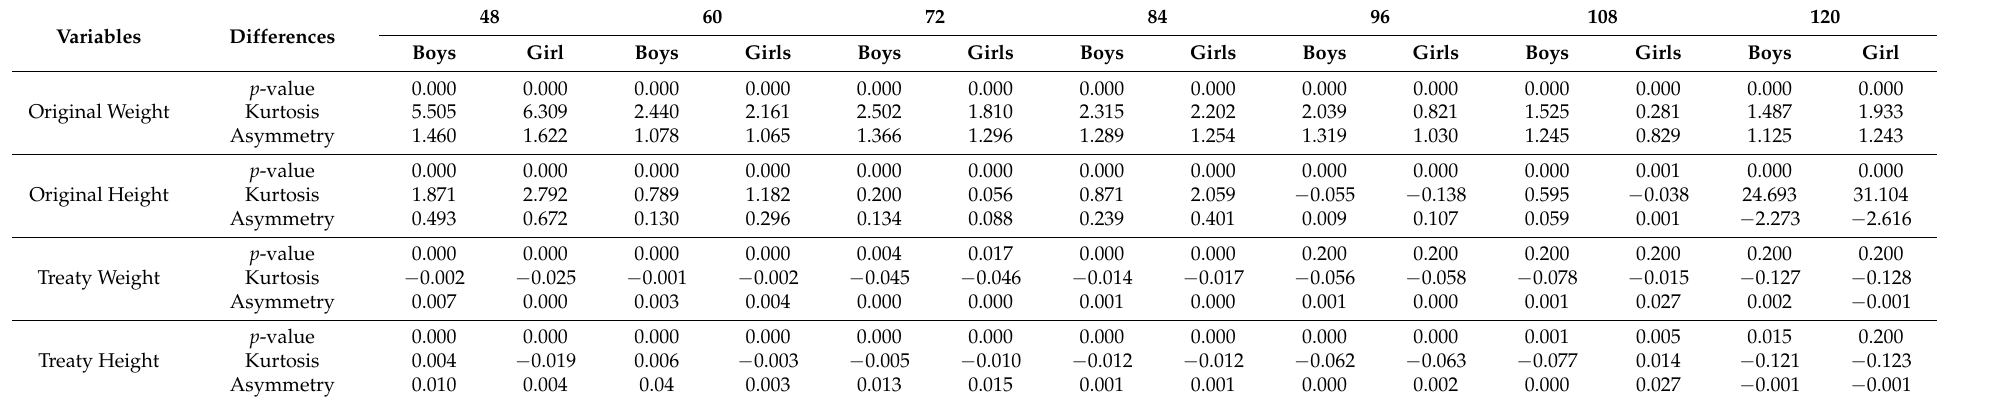
Table 2. Differences in kurtosis, asymmetry of weight and height from 4 to 10 years old after the two-step transformation Process.